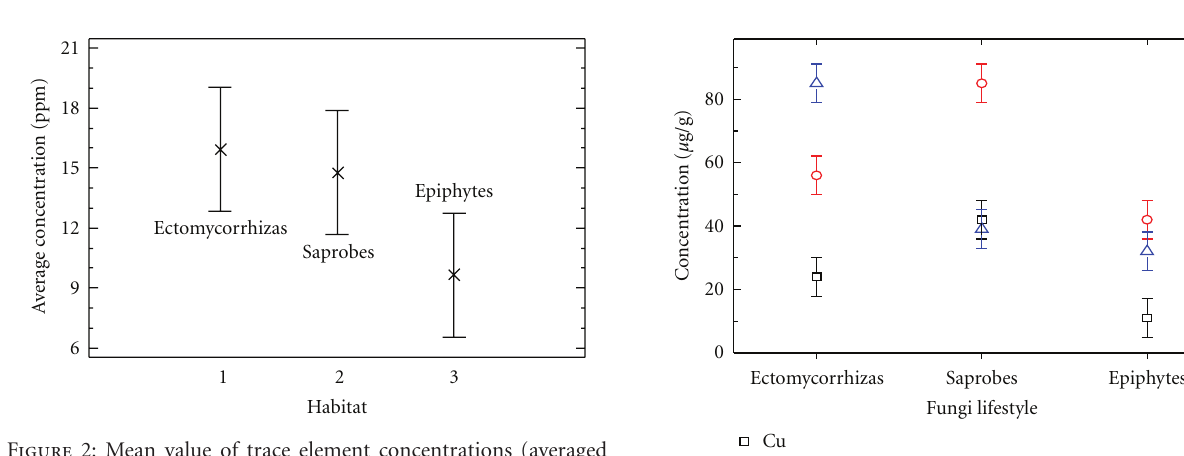
Figure 1: Mean value of trace element content averaged over the 18 fungi species studied. The dashed line separates the elements with statistically significant di ff erent values following an ANOVA test.